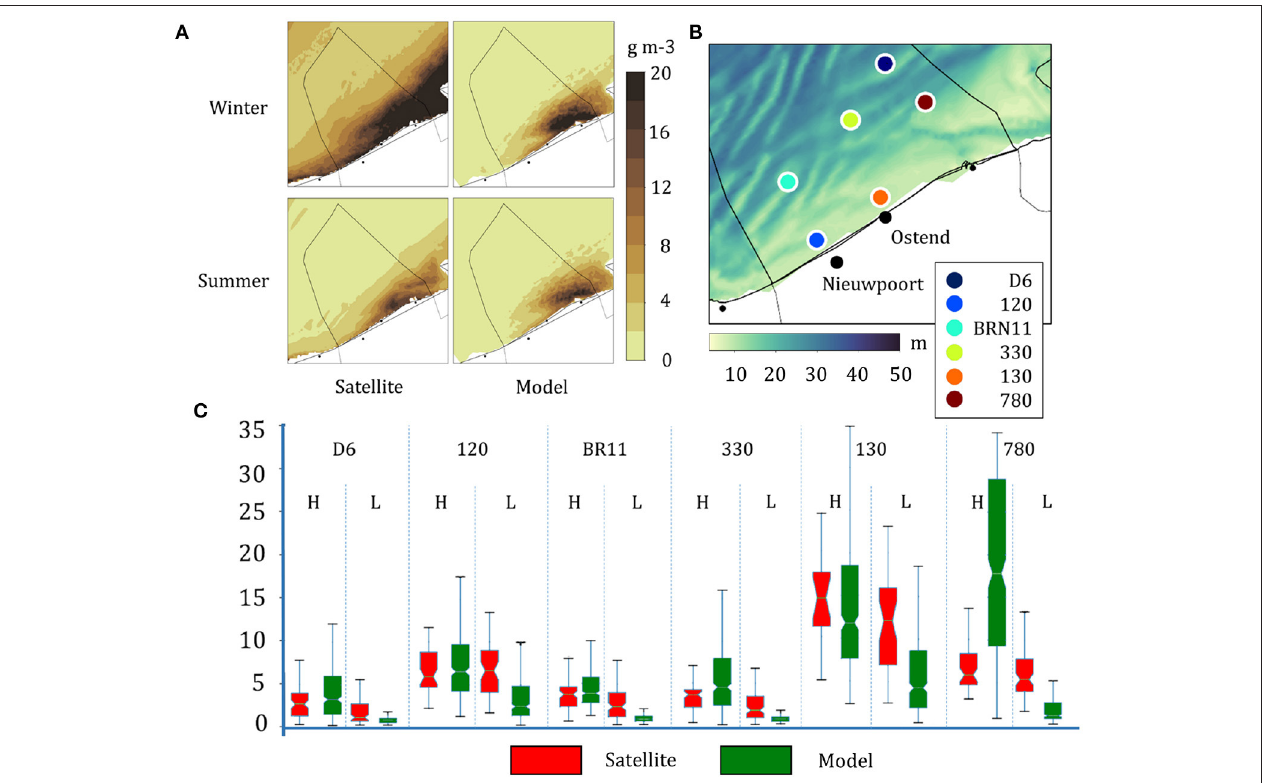
FIGURE 5 | (A) Surface SPM in winter (top) and summer (bottom), left column—satellite, right column—model. (B) Positions of the monitoring stations (background—bathymetry). (C) Satellite and model SPM boxplots at those monitoring stations for spring (H) and neap (L) tide.